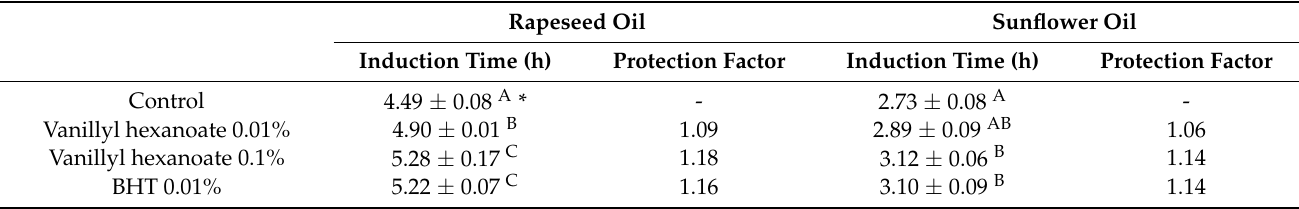
Table 4. Oxidation induction times [h] for rapeseed and sunflower oils with or without addition of vanillyl hexanoate (0.01% or 0.1%) or BHT (0.01%) and calculated protection factors. Rapeseed Oil Sunflower Oil Induction Time (h) Protection Factor Induction Time (h) Protection Factor Control 4.49 ± 0.08 A * - 2.73 ± 0.08 A - Vanillyl hexanoate